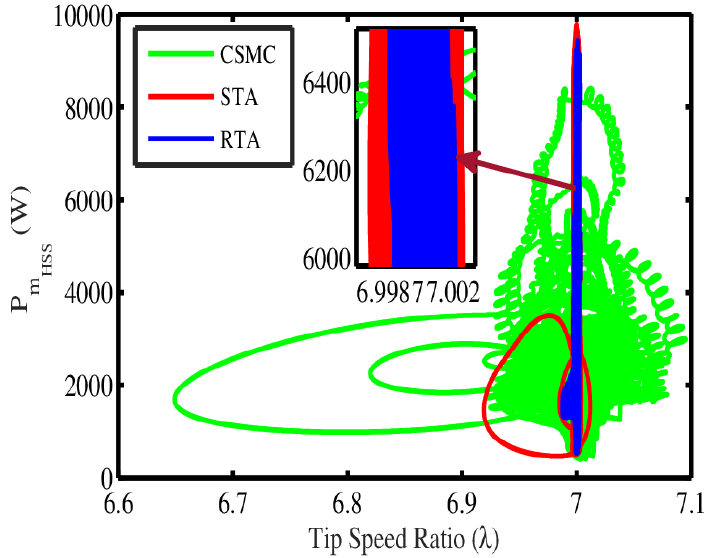
Figure 11. High-speed shaft side power versus tip speed ratio.